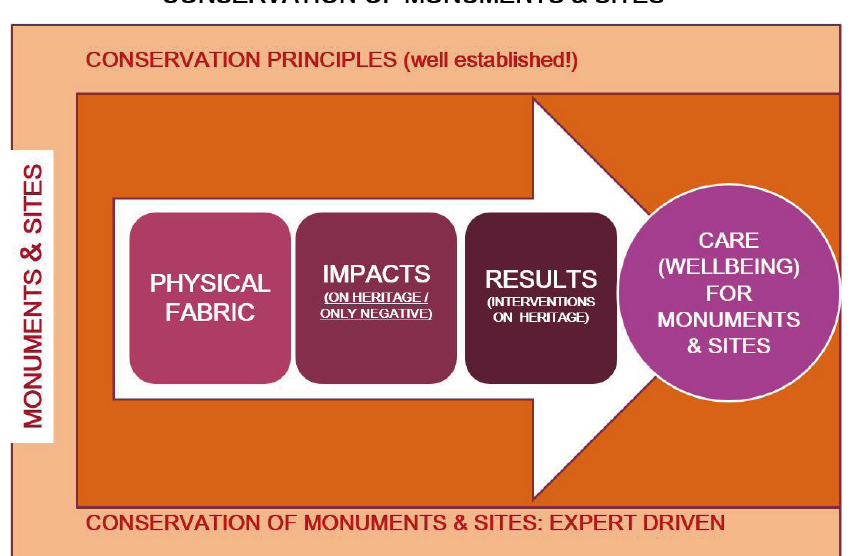
Figure 1 Approach to Conservation of Monuments and Sites (Source: Wijesuriya 2016b).